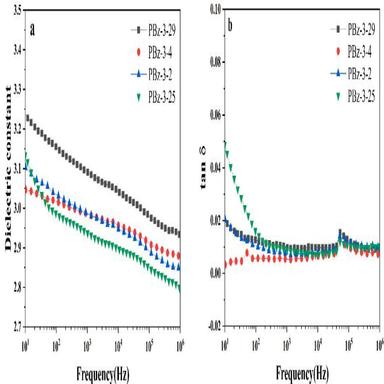
(a) Dielectric constant, and (b) dielectric loss of the polybenzoxazines.